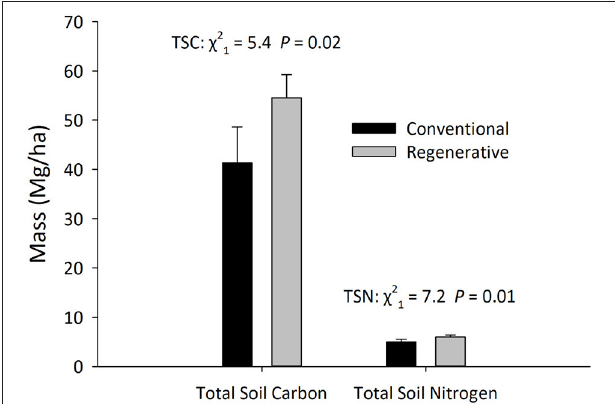
FIGURE 3 | The differences in carbon and nitrogen through the 0–6,000mg Equivalent Soil Mass (ESM) layer ( ∼ 0–60cm) in regenerative and conventional almond orchards (mean ± SEM). Statistical significance was determined using Linear Mixed Models, in which treatment and clay percentage were fixed factors, and farm was a random factor ( N = 49 observations across 16 orchards, α = 0.05).